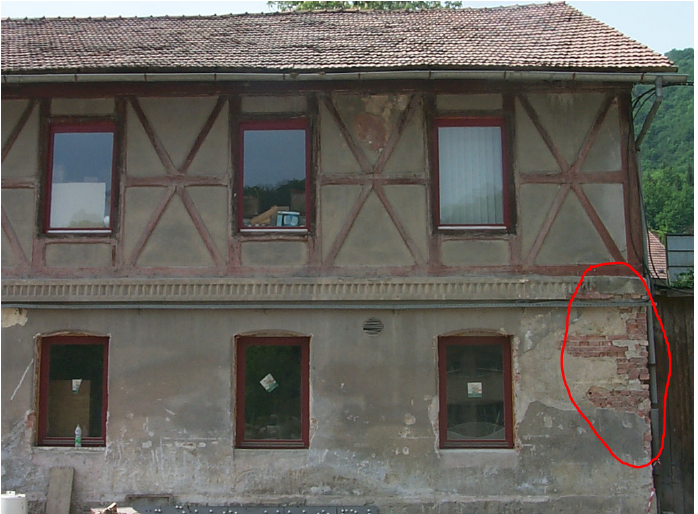
Figure 6. Existing masonry brick building (mortar type M1) at the age of 70 years and corresponding localized damage after the assumed 105 F/T cycles analyzed for a hypothetical scenario.